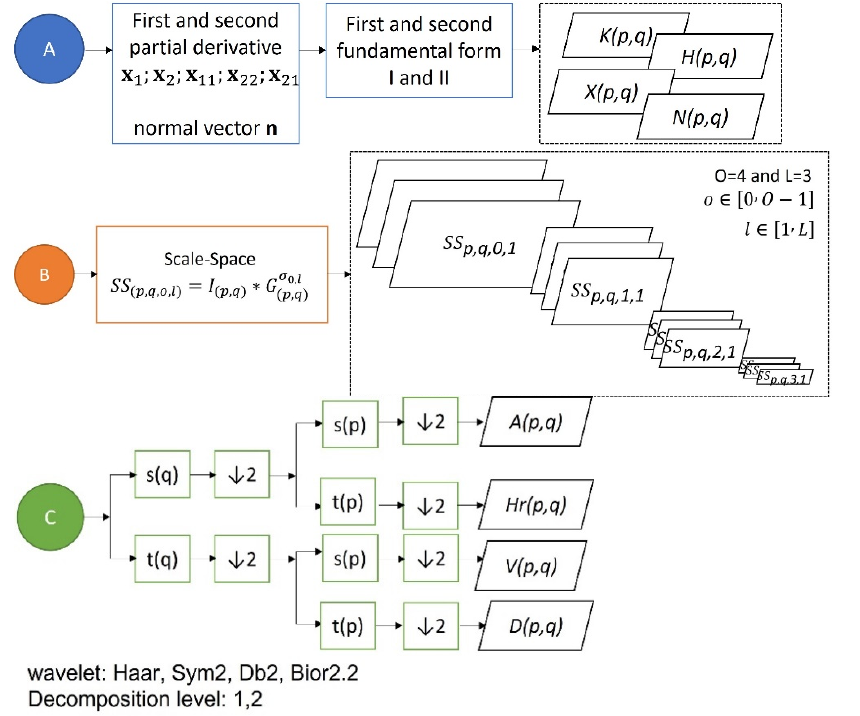
Figure 1. The overall flowchart of the proposed idea. Connectors A, B, and C detail the curvature- based, scale-space, and discrete wavelet transform processes.